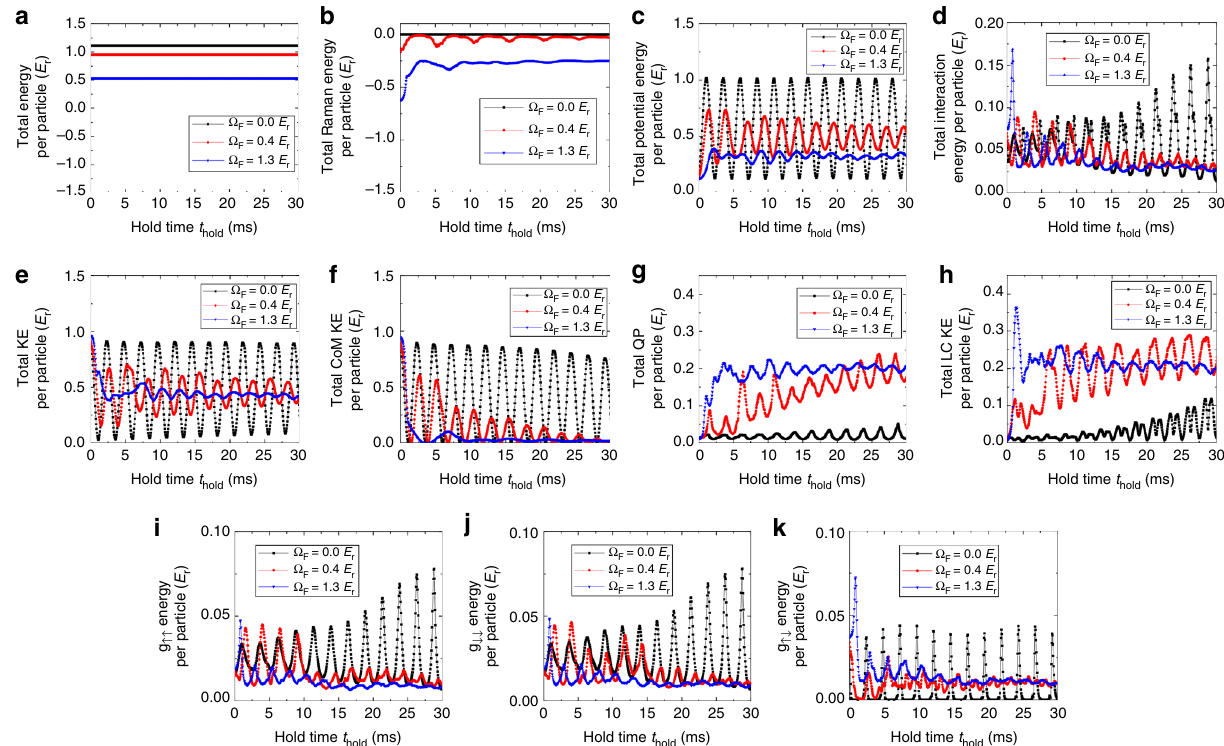
Fig. 8 Time ( t hold ) evolution of different forms of energies per particle at different Ω F as calculated by GPE. a The total energy is the sum of the total Raman energy, total potential energy, total interaction energy, and the total KE. The result in a con fi rms that the total energy is conserved during t hold . b Total Raman energy. c Total potential energy. d Total interaction energy, sum of the bare interaction energies in i – k . e Total KE, sum of different types of kinetic energies in f – h . f Total CoM KE. g Total QP. h Total LC KE. i g ↑↑ interaction energy. j g ↓↓ interaction energy. k g ↑↓ interaction